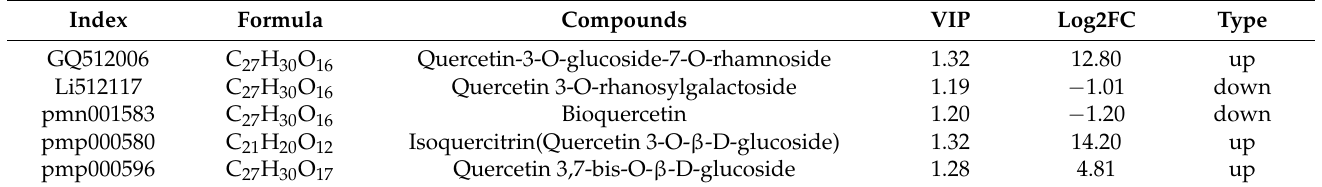
Table 2. Differential metabolites associated with flavonoid synthesis within the roots and stems of mature A. ilicifolius .